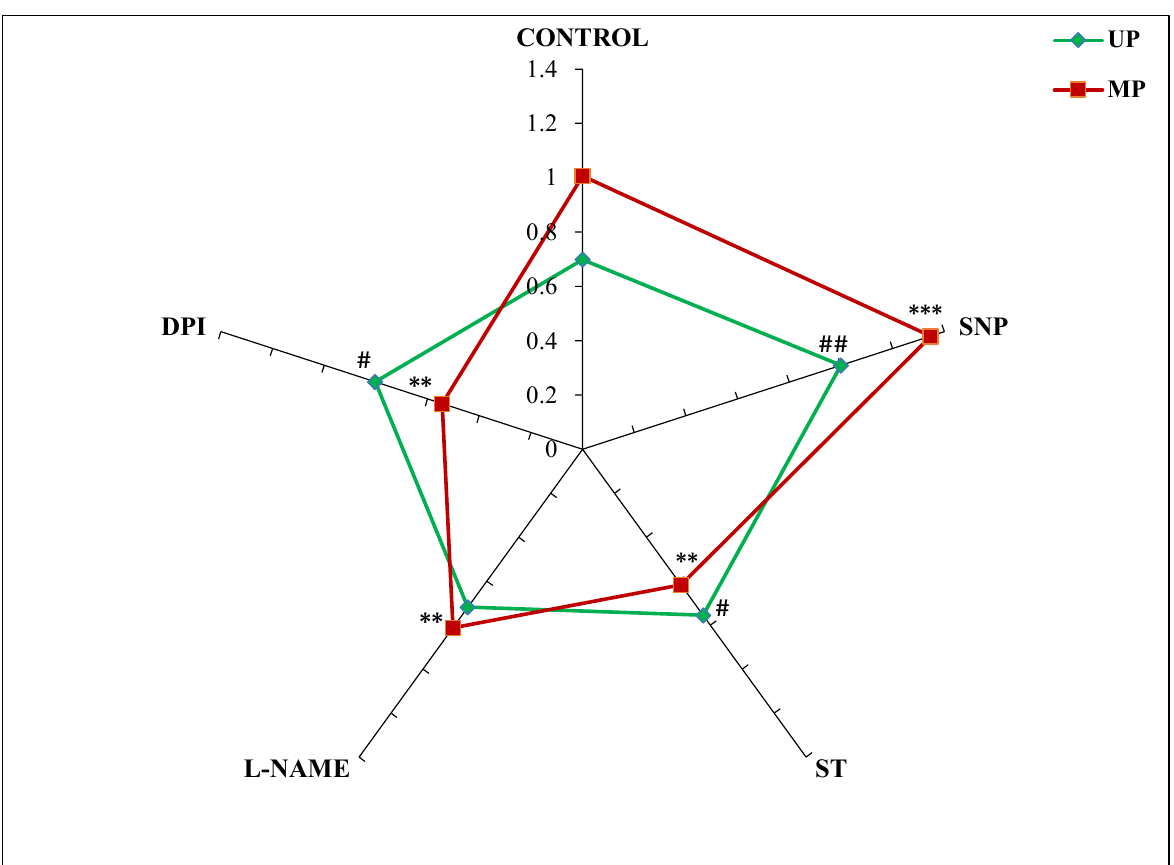
Figure 1. Effect of magnetopriming (200 mT SMF for 1 h) on salt tolerance index (STI) based on dry weight of 72 h germinated soybean seeds grown in different modulators of NO and ROS production under non-saline and saline (50 mM NaCl) conditions. Unprimed = UP, Magnetoprimed = MP. The data are represented as mean ± SE (n = 3). ## p < 0.01, # p < 0.05 indicates the significant difference between STI of unprimed seeds in the absence (control) versus presence of modulators of NO/ROS production under non-saline or saline conditions; *** p < 0.001, ** p < 0.01 indicates the significant difference between STI of MP seeds in the absence (control) versus presence of modulators of NO/ROS production under non-saline or saline conditions.